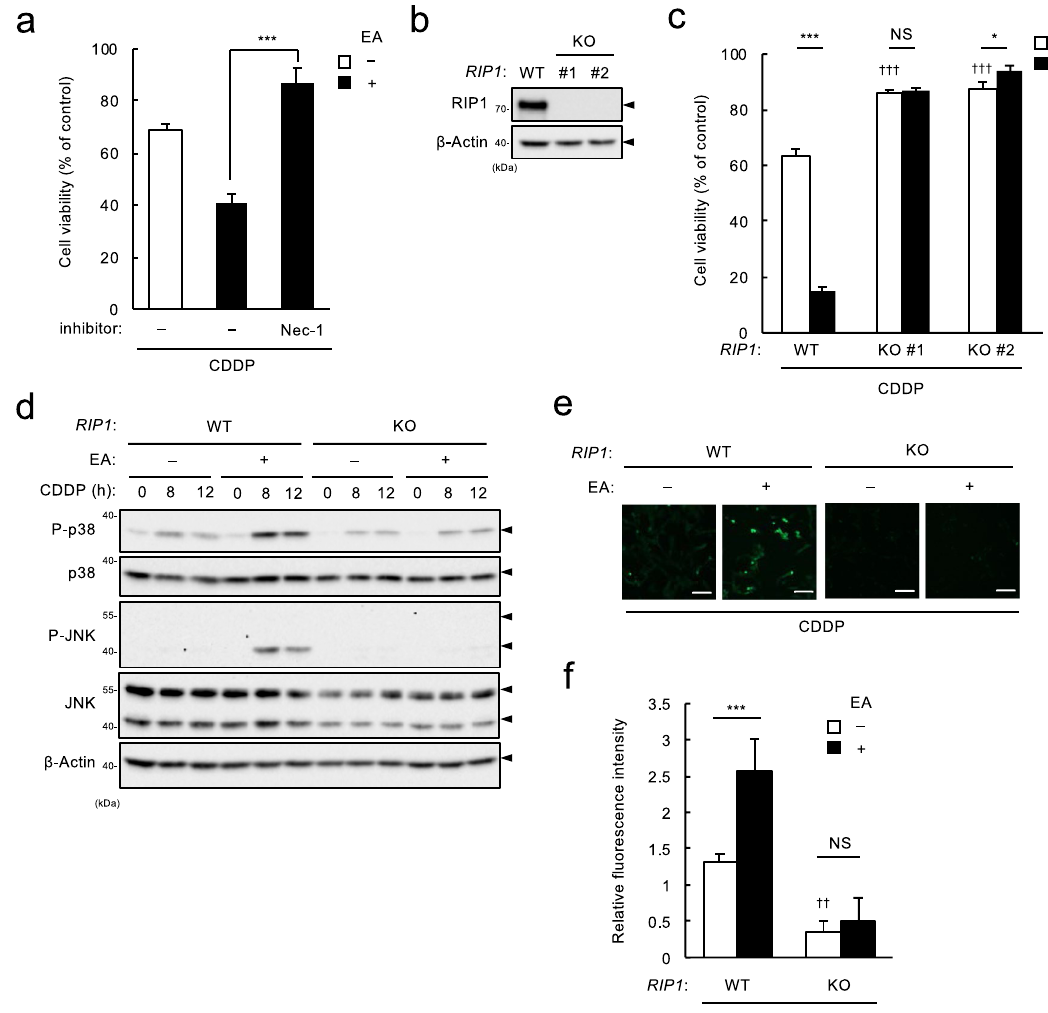
Figure 5. RIP1 plays a critical role in EA-mediated pro-apoptotic signaling in response to CDDP. ( a ) U2OS cells were pretreated with or without 200 µM EA for 11.5 h, treated with RIP1 inhibitor Necrostatin-1 (Nec-1, 30 μM) for 0.5 h, and then stimulated with 40 μM CDDP for 24 h, subjected to cell viability assay. Data shown are the mean ± SD (n = 3). ( b ) RIP1 WT and KO U2OS cells were lysed and subjected to immunoblotting with the antibodies against RIP1 and β-actin. ( c ) RIP1 WT and KO U2OS cells were pretreated with or without 200 μM EA for 12 h, and then treated with 40 μM CDDP for 24 h, subjected to cell viability assay. Data shown are the mean ± SD (n = 3). ††† p < 0.001 (vs. WT cells without EA pretreatment). ( e ) RIP1 WT and KO U2OS cells were pretreated with or without 200 µM EA for 12 h, and then stimulated with 40 μM CDDP for 0, 8 and 12 h. Cell lysates were subjected to immunoblotting with the indicated antibodies. ( f and g ) RIP1 WT and KO U2OS cells were pretreated with or without 200 µM EA for 12 h, and then stimulated with 40 μM CDDP for 6 h, followed by incorporation of a ROS-sensitive fluorescent probe DCFH-DA for 30 min. Green fluorescence was observed ( f ) and relative ROS levels were calculated ( g ), shown as mean ± SD (n = 3, normalized to the ROS level in the cells without fatty acid and CDDP). Scale bar, 100 µm. †† p < 0.01 (vs. WT cells without EA